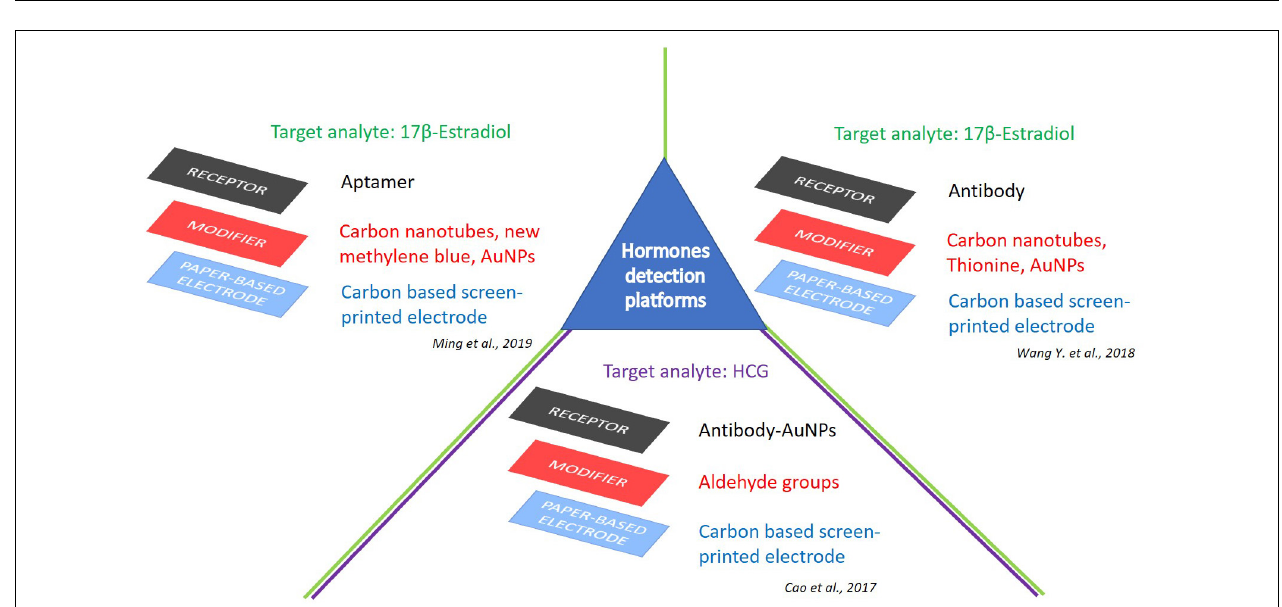
FIGURE 2 | e-PAD platforms for detection of antioxidants. Target analytes: Ascorbic acid (Kit-Anan et al., 2012; Cinti et al., 2018), and cysteine (Santhiago et al., 2013).